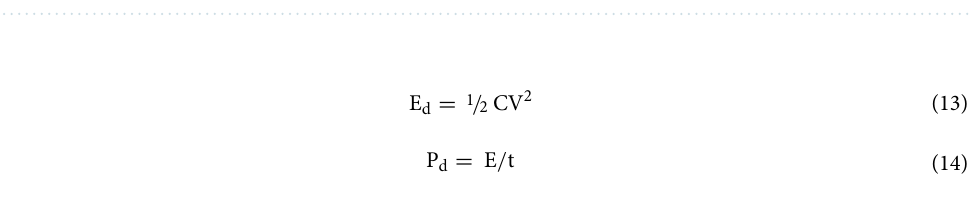
Table 3. The specific capacitance value GCD for the GNs in 1 M H 3 PO 4